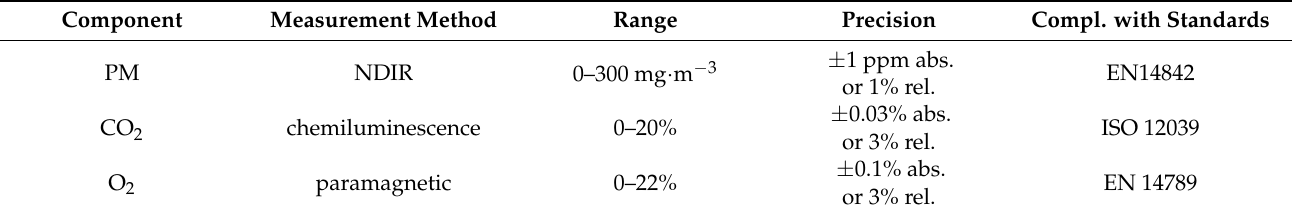
Table 5. Technical parameters of the Testo 380